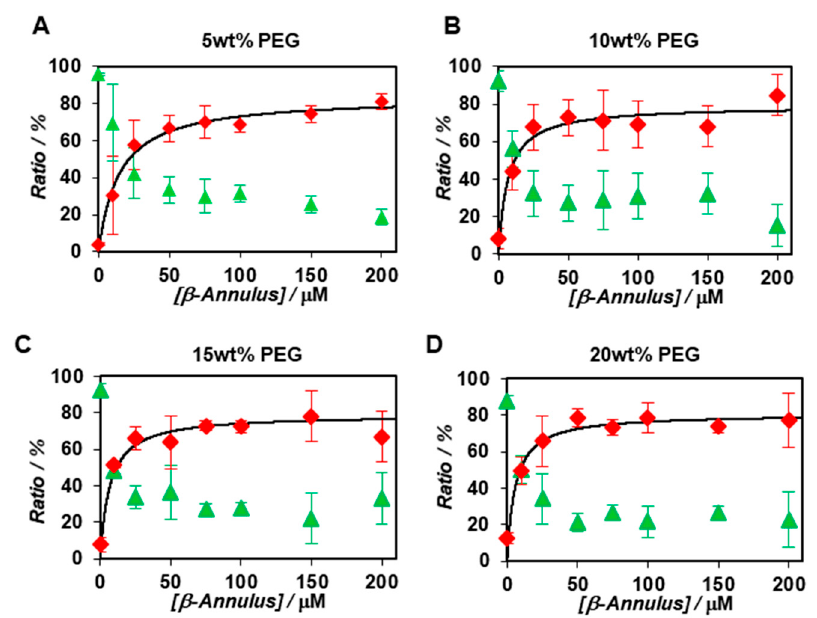
Figure 4. Concentration dependence of β -annulus peptides on the ratio of the fast (green) and slow components (red) determined by FCS curve fitting ( N = 3) at a constant concentration of the BODIPY- β -annulus peptide (0.1 μ M) in the presence of 5 wt % ( A ), 10 wt% ( B ), 15 wt% ( C ), 20 wt% ( D ) PEG 2000 at 25 °C. Table 1. K d and Δ G calculated for the formation of artificial virus capsids using the ratio of the slow component. Solvent K d / μ M Δ G /kJ mol − 1 10 mM Tris-HCl buffer (pH 7.0)